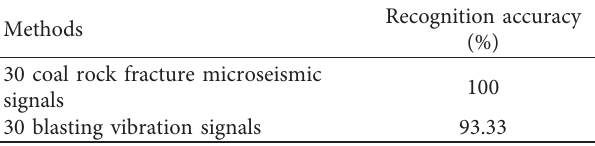
Table 3: Identification results of the proposed algorithm.